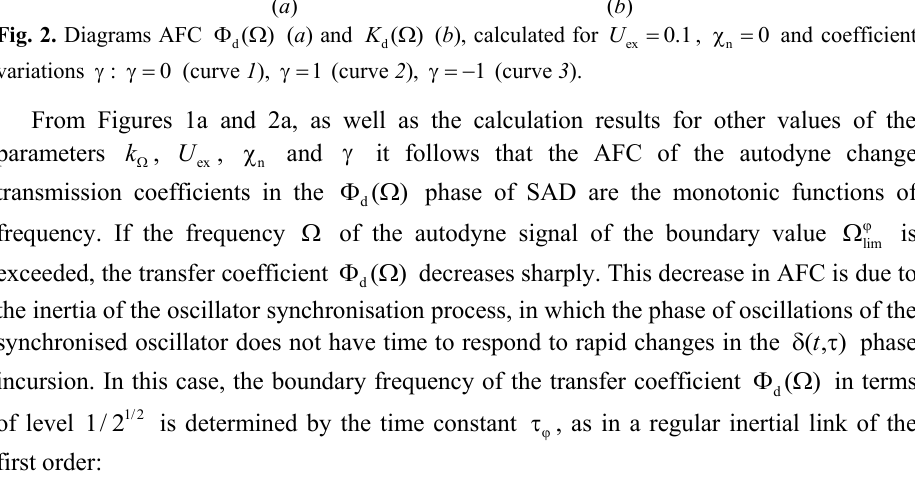
Fig. 2. Diagrams AFC